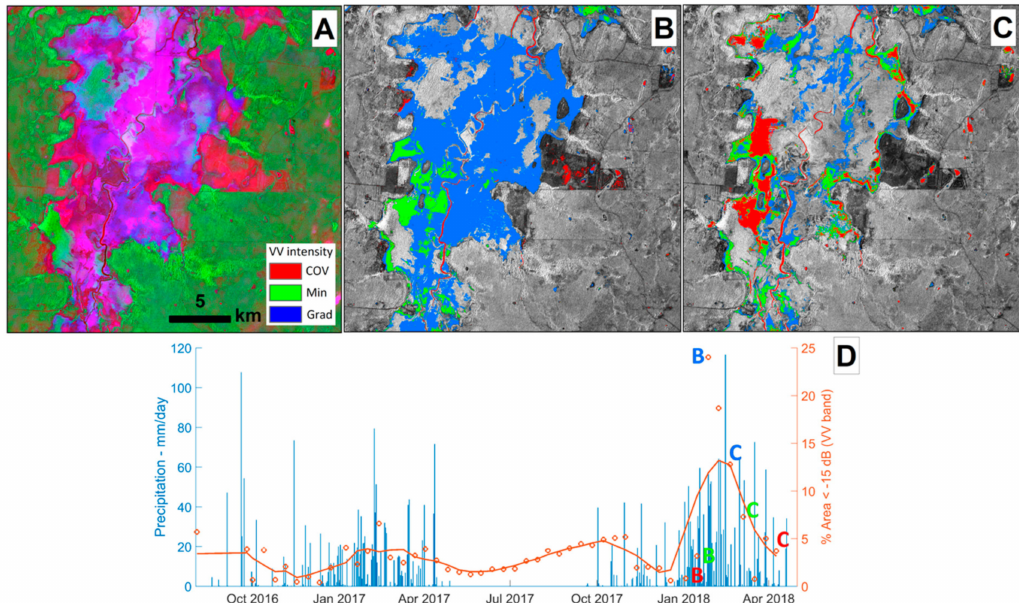
Figure 3. Assessment of the flooding of the Wildman coastal plain, Northern Territory, derived from Sentinel-1 intensity imagery between 20170108 and 20181222. ( A ) Red-green-blue (RGB) map with red assigned to the Coefficient of Variation (COV), green assigned to the minimum (Min), and blue assigned to the temporal gradient (Grad), to show seasonally flooded areas, vegetated, and rapidly flooded areas, respectively. ( B ) Thresholding of the images (at − 15 dB) over three dates during the early wet season shows the progression of flooded extent. ( C ) Thresholding of the images (at − 15 dB) over three dates at the end of the wet season shows the recession of flooded areas. ( D ) The time-series of precipitation (blue) and SAR-derived percentage of flooded areas (orange circles, where the orange line is a moving average of five images). The images used in B and C are labelled with color-coded